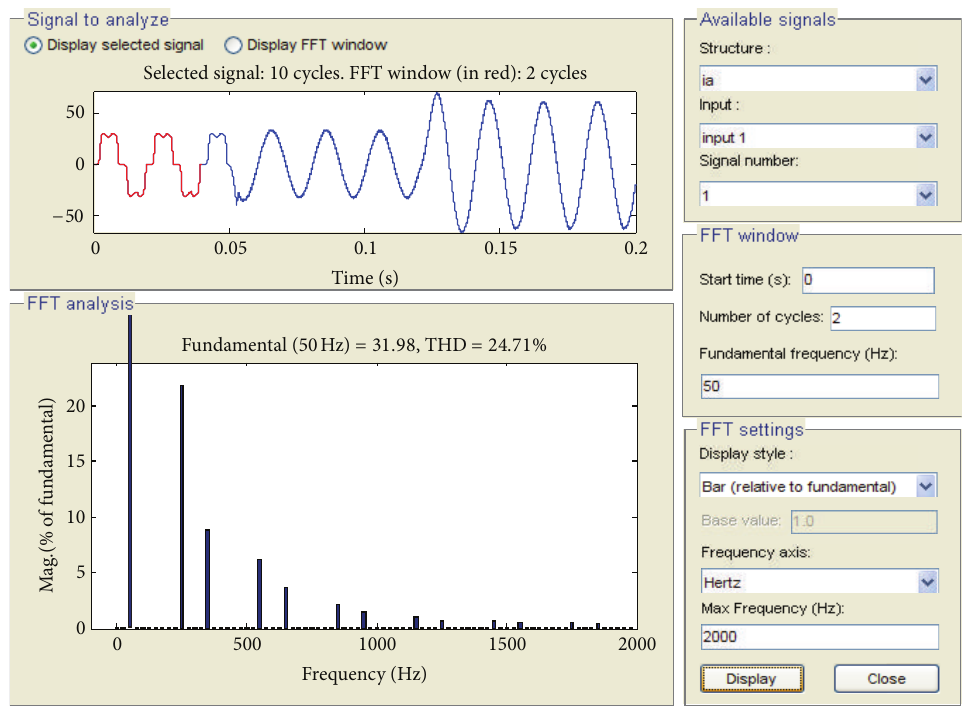
Figure 5: Current harmonic analysis from 0 to 0.04 second.